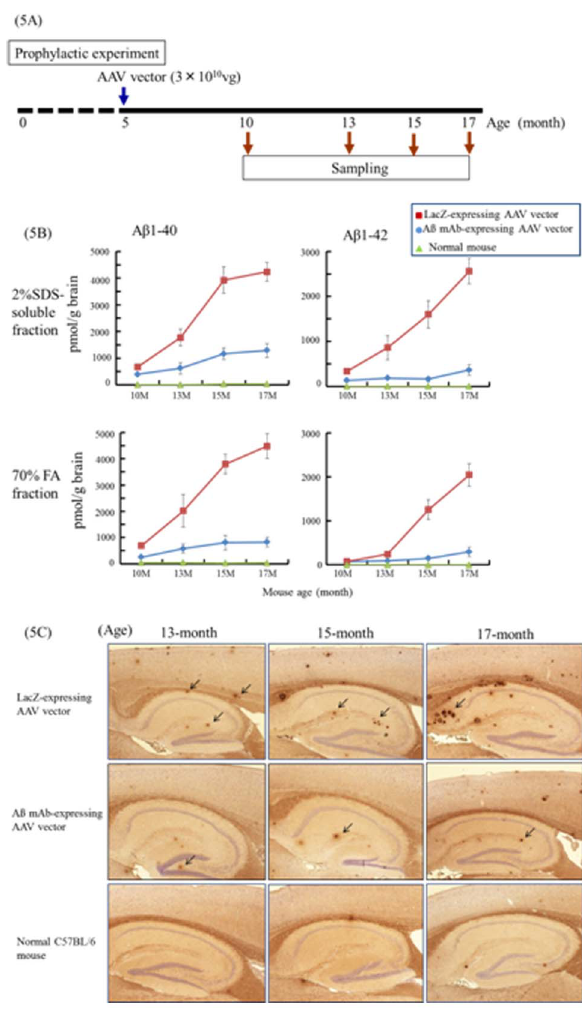
Figure 5. Prophylaxis of AD using Aß mAb-expressing AAV vector. Five-month old Tg2576 mice were injected i.m. with 3 6 10 10 Aß mAb-expressing AAV. (A) Scheme of experiment. (B) The amount of Aß protein in brain extracts was determined using anti-Aß Ab-coated ELISA plates at age 10-, 13-, 15- and 17-month old (4–5 mice per time point). C57BL/6 mice were used as controls. Data are presented as mean 6 SE. (C) Brain sections from Tg2576 or C57BL/6 mice were examined for Aß deposits by immunohistostaining using rabbit anti-human beta amyloid 1–42 polyclonal antibody.